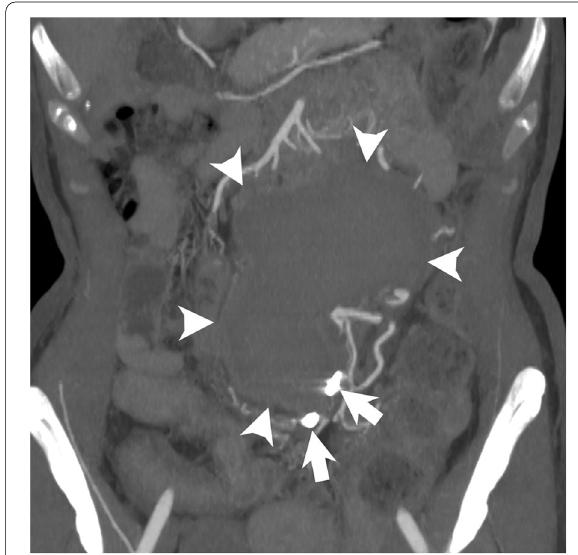
Fig. 3 Coronal partial maximum intensity projection image reconstructed from computed tomography angiography obtained 3 months after transcatheter arterial embolization showing the lack of enhancement of the superior rectal artery trunk aneurysm. Note the coils deployed proximally and distally to the aneurysm (arrows) and decreased size of the retroperitoneal hematoma (arrowheads)